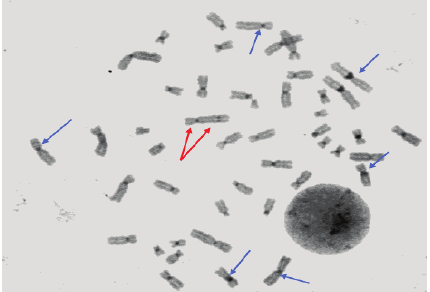
F 3: CBG Karyotype: red arrows show the two centromeres on dicentric X chromosome; blue arrows point to normal chromo- somes (one centromere).